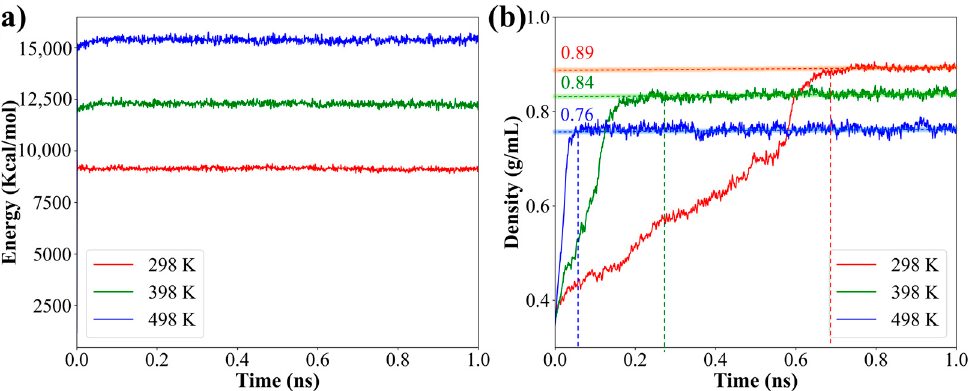
Figure 2. ( a ) Energy and ( b ) density of a heavy oil droplet as a function of simulation time at 298 K, 398 K, and 498 K, respectively.